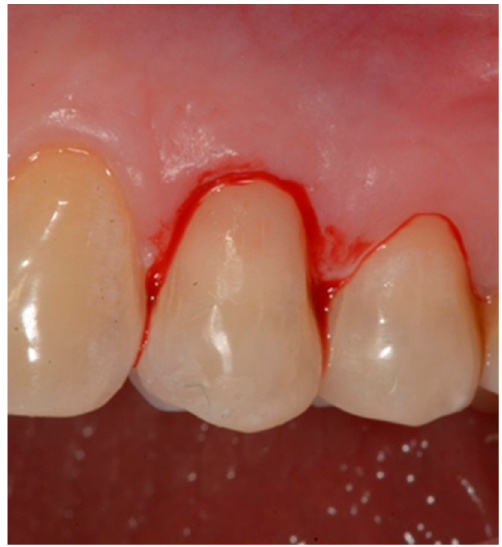
Figure 9. De ‐ epithelization of the sulcus until bleeding was performed. All the restorative procedures were performed by a single